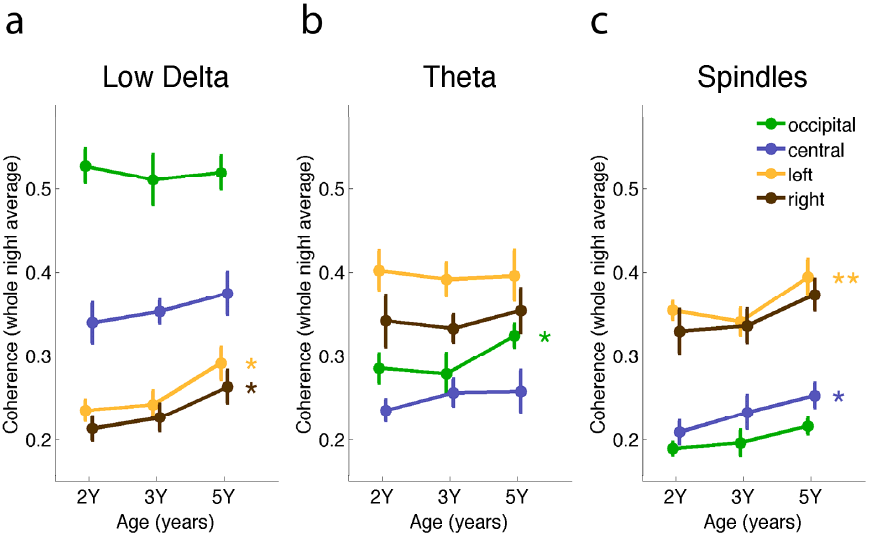
Figure 3. Development of sleep EEG coherence is region- and frequency-specific. Coherence data (inter-hemispheric “occipital” and “central”; intra-hemispheric “left” and “right”) were averaged for the whole night (mean ± SEM). Repeated measures ANOVA reached significance in the “left” and “right” hemisphere for low-delta coherence, inter-hemispheric “occipital” areas for theta and inter-hemispheric “central” areas and in the “left” hemisphere for spindle coherence, as indicated with asterisks ( * p < 0.05; ** p < 0.01). Post-hoc two-tailed paired t -tests revealed developmental differences mainly between 2Y–5Y (see text for details). In subsequent analysis, frequency bands were defined as ( a ) low-delta (0.8–2 Hz); ( b ) theta (4.8–7.8 Hz); and ( c ) sleep spindles (10–14